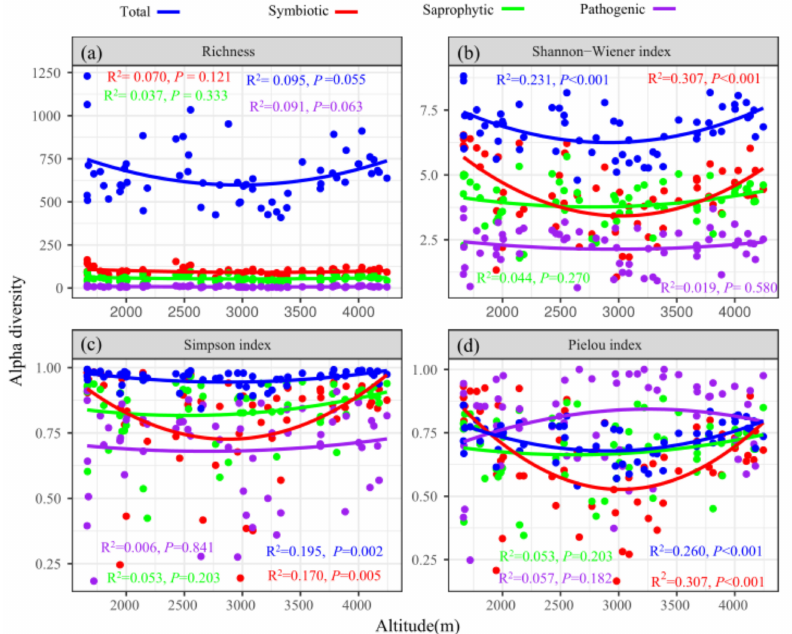
Figure 4. The α -diversity (richness ( a ), Shannon–Wiener index ( b ), Simpson index ( c ), Pielou index ( d )) patterns of soil fungi along altitude gradients.